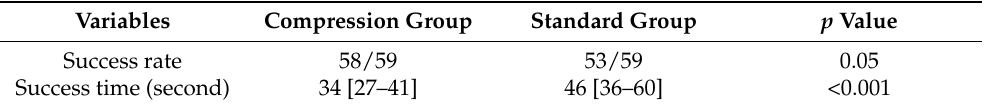
Table 3. Success rate and time of ultrasound-guided radial artery catheterization at the first attempt. Variables